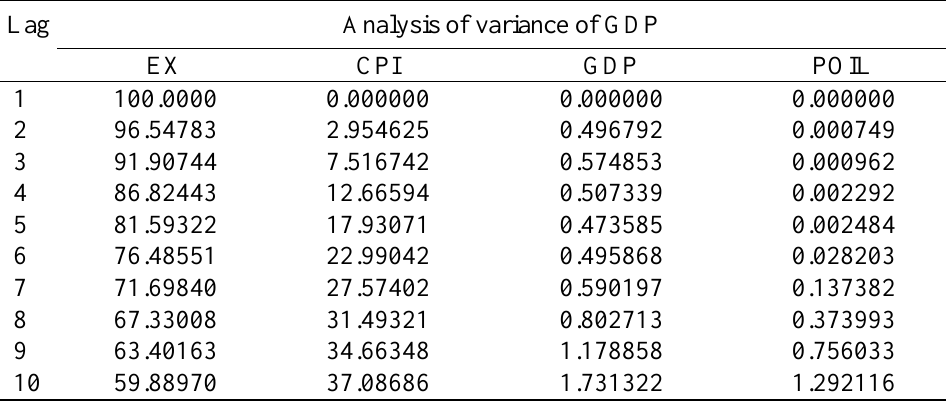
Table 8. Analysis of variance for exchange